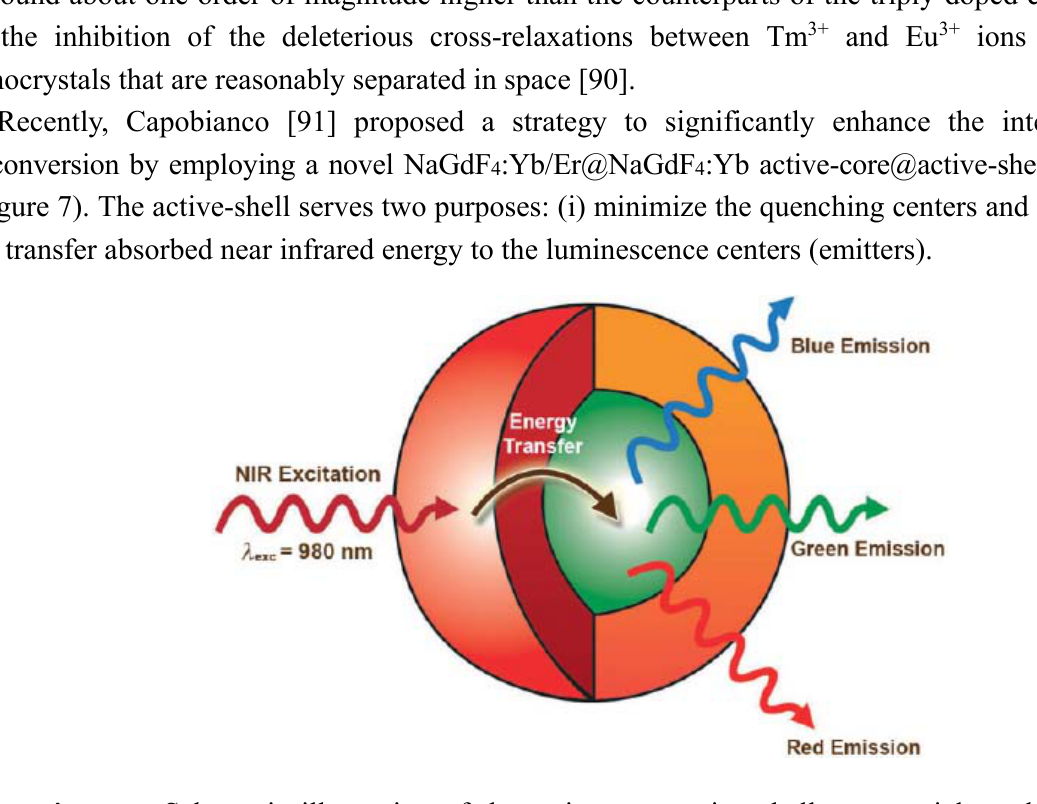
Figure 7. Schematic illustration of the active core-active shell nanoparticle architecture showing the absorption of NIR near infrared light by the Yb 3+ -rich shell (red) and subsequent energy transfer to the Er 3+ ,Yb 3+ -doped core (green), which leads to upconverted blue, green, and red emissions. Reproduced from [91]. Copyright 2009, John Wiley and